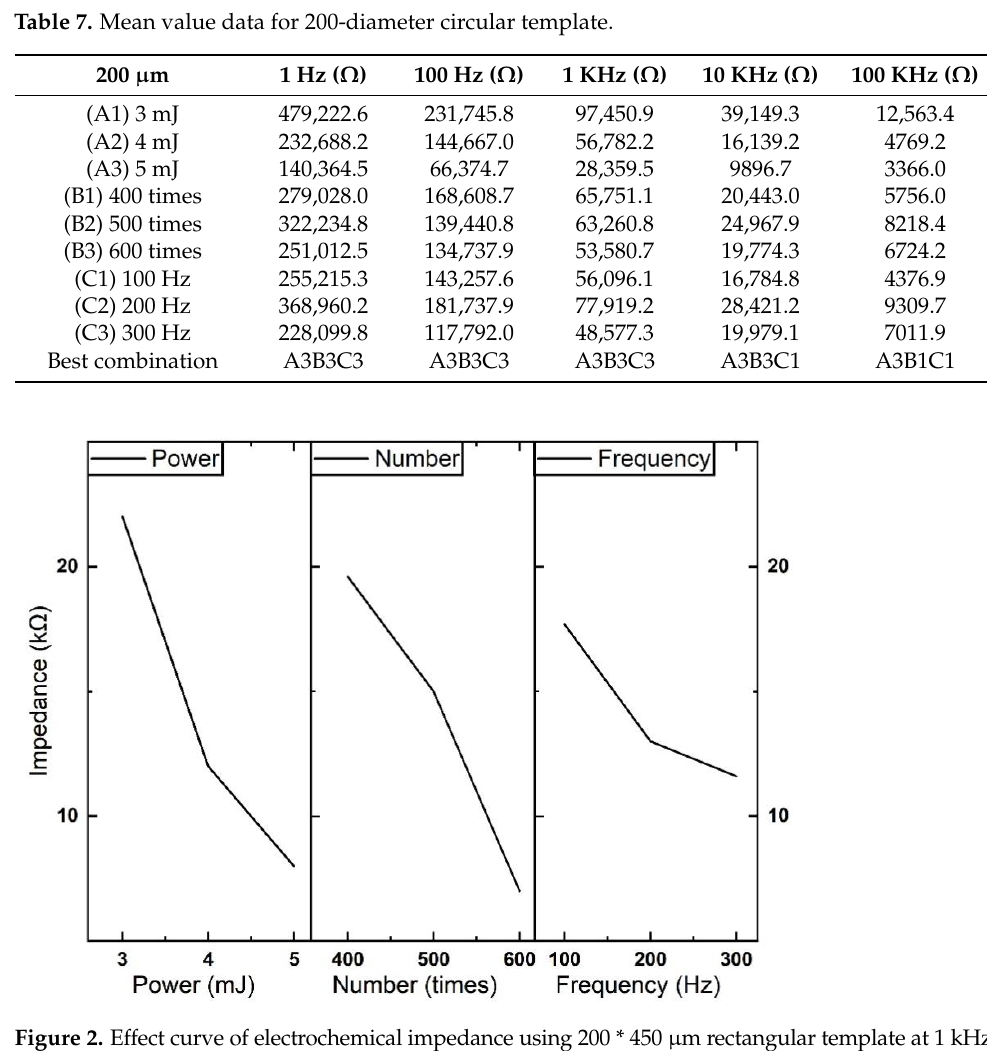
Figure 2. Effect curve of electrochemical impedance using 200 * 450 μ m rectangular template at 1 kHz.